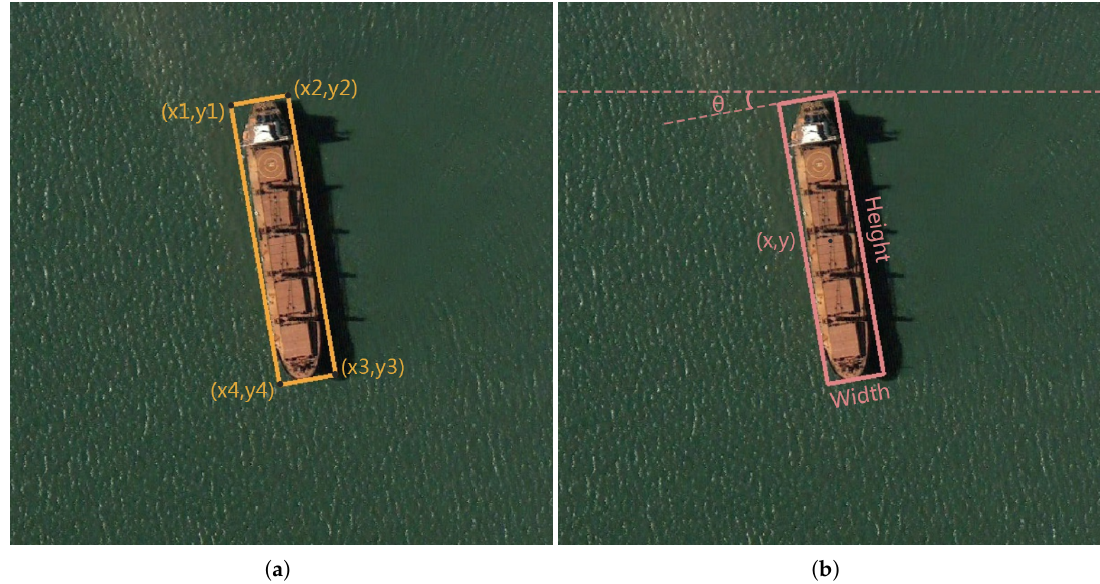
Figure 4. ( a ) the four points coordinates of quadrilateral ship ground truth; ( b ) the inclined rectangle ship ground truth in our